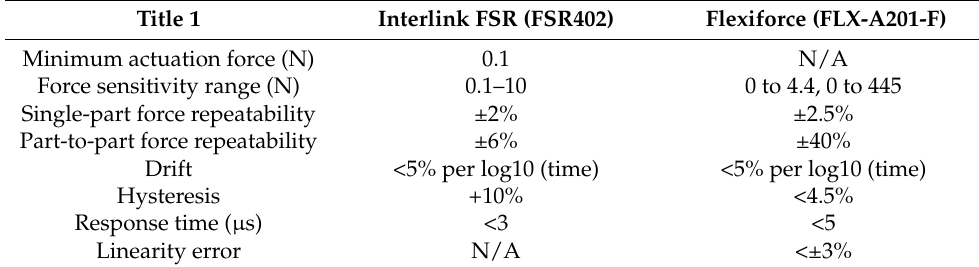
Table 1. FSR Interlink and Flexiforce properties from data sheets